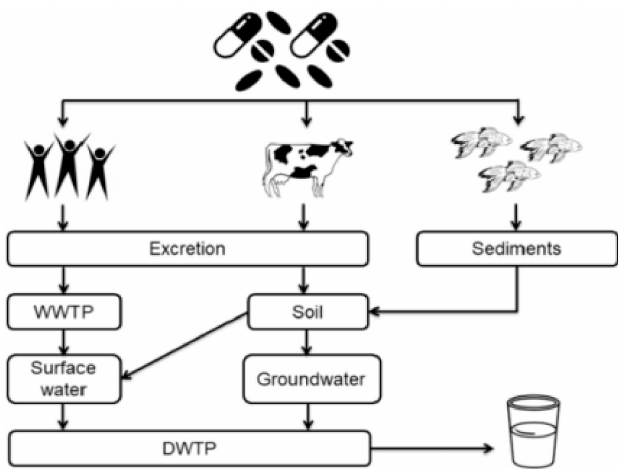
Figure 3. Pharmaceuticals’ fates and environmental pathways, copied with permission from Ref. [54], Copyright, 2019,